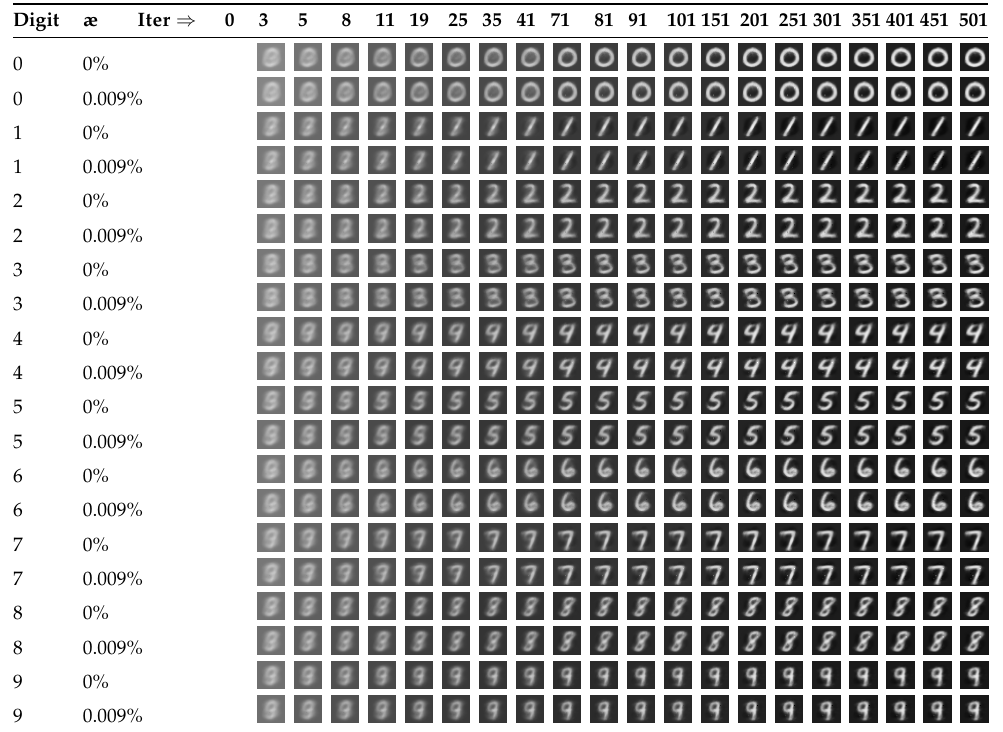
Table 4. Observations of multiple-cue recall operation with RAN model of MNIST